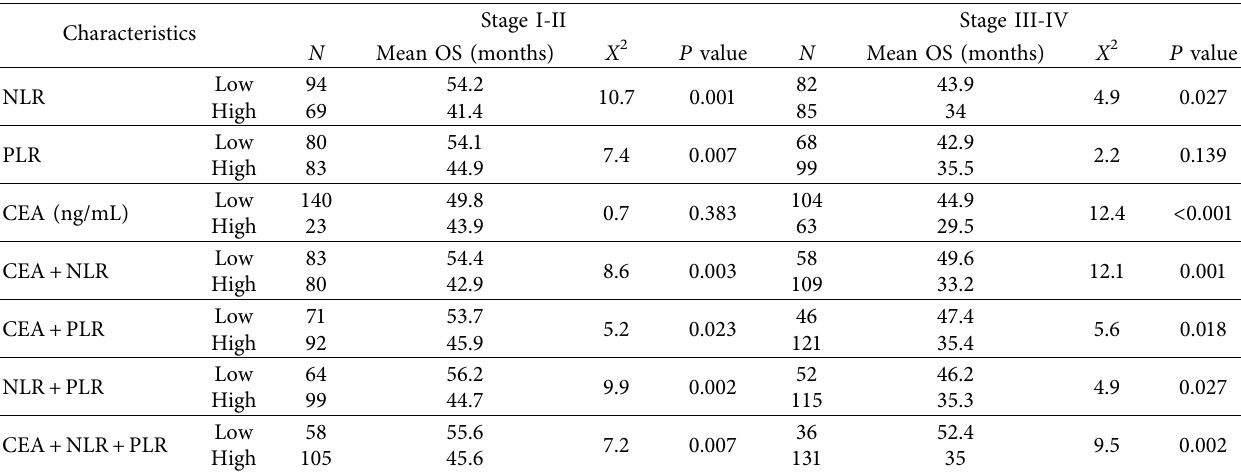
Table 2: Kaplan–Meier survival analysis and log-rank test compared in the clinical pathological stage.